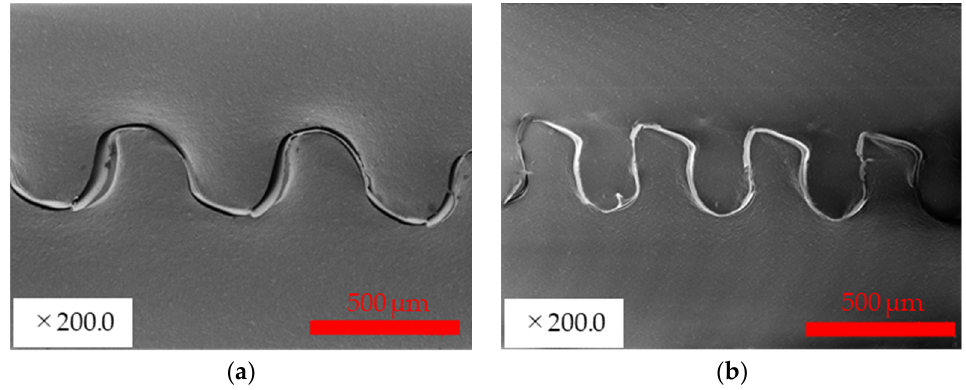
Figure 3. Example of SEM cross-sectional view of the created interconnect: ( a ) fabricated using gears with module 0.2 and 0% pre-stretch; ( b ) fabricated using gears with module 0.2 and 75% pre-stretch.